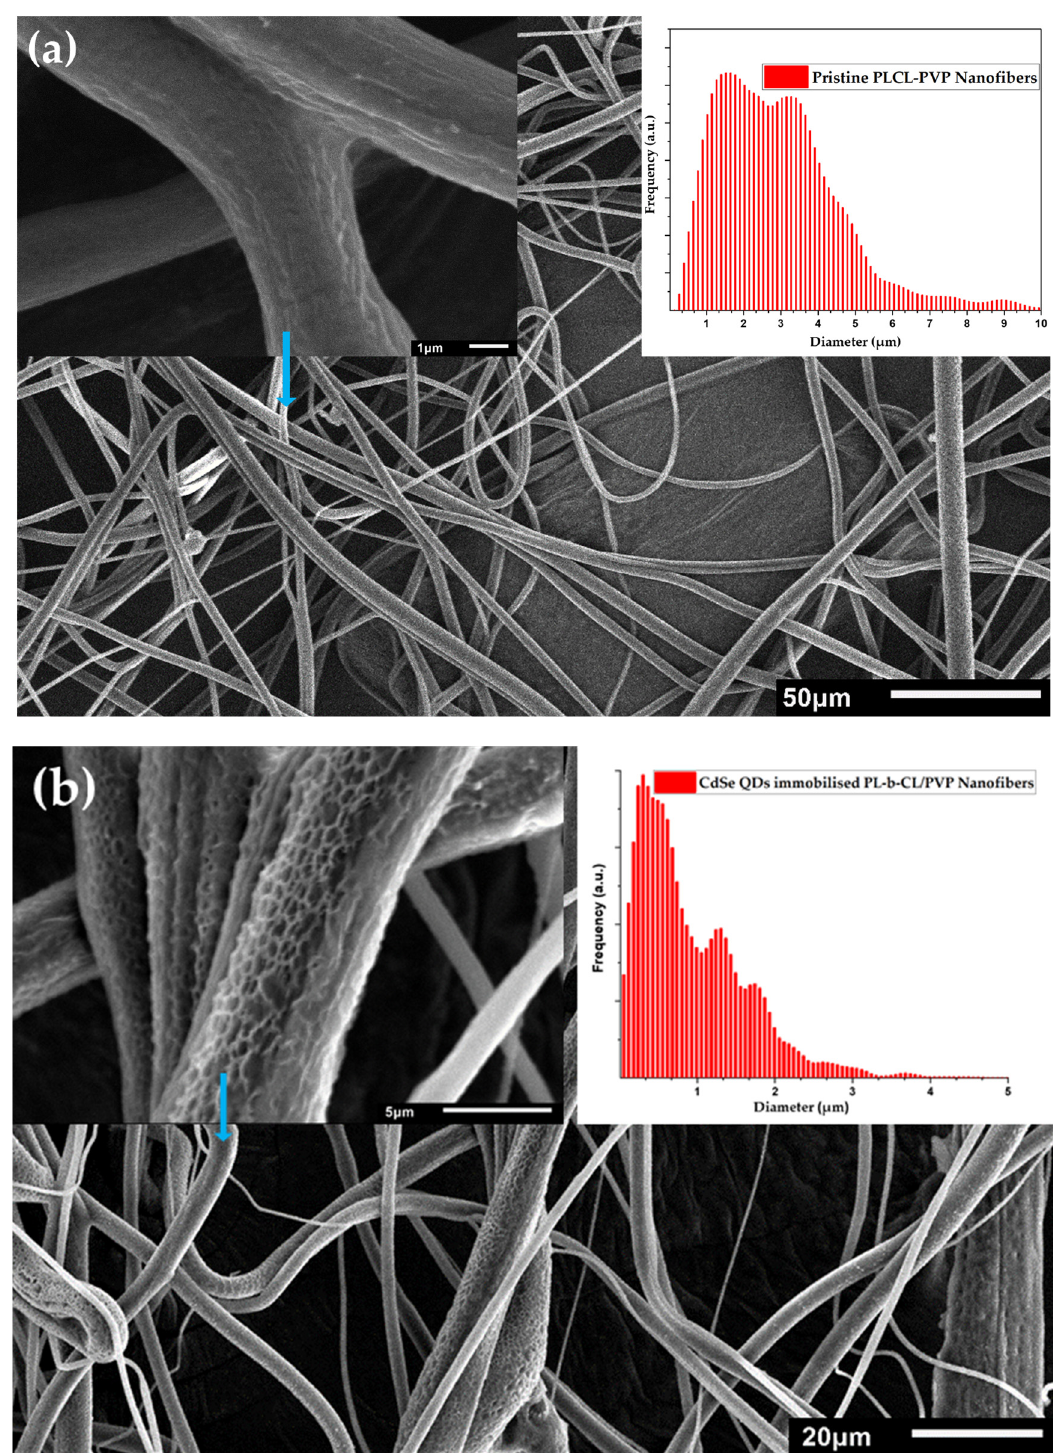
Figure 4. Scanning electron micrograph displaying morphology of electrospun nano fi bers, their diameter distribution (inset right) and magni fi ed view exhibiting rough/porous features on fi ber surface (inset left): ( a ) pristine PL-b-CL/PVP nano fi bers; ( b ) CdSe QDs-immobilized PL-b-CL/PVP nano fi bers.